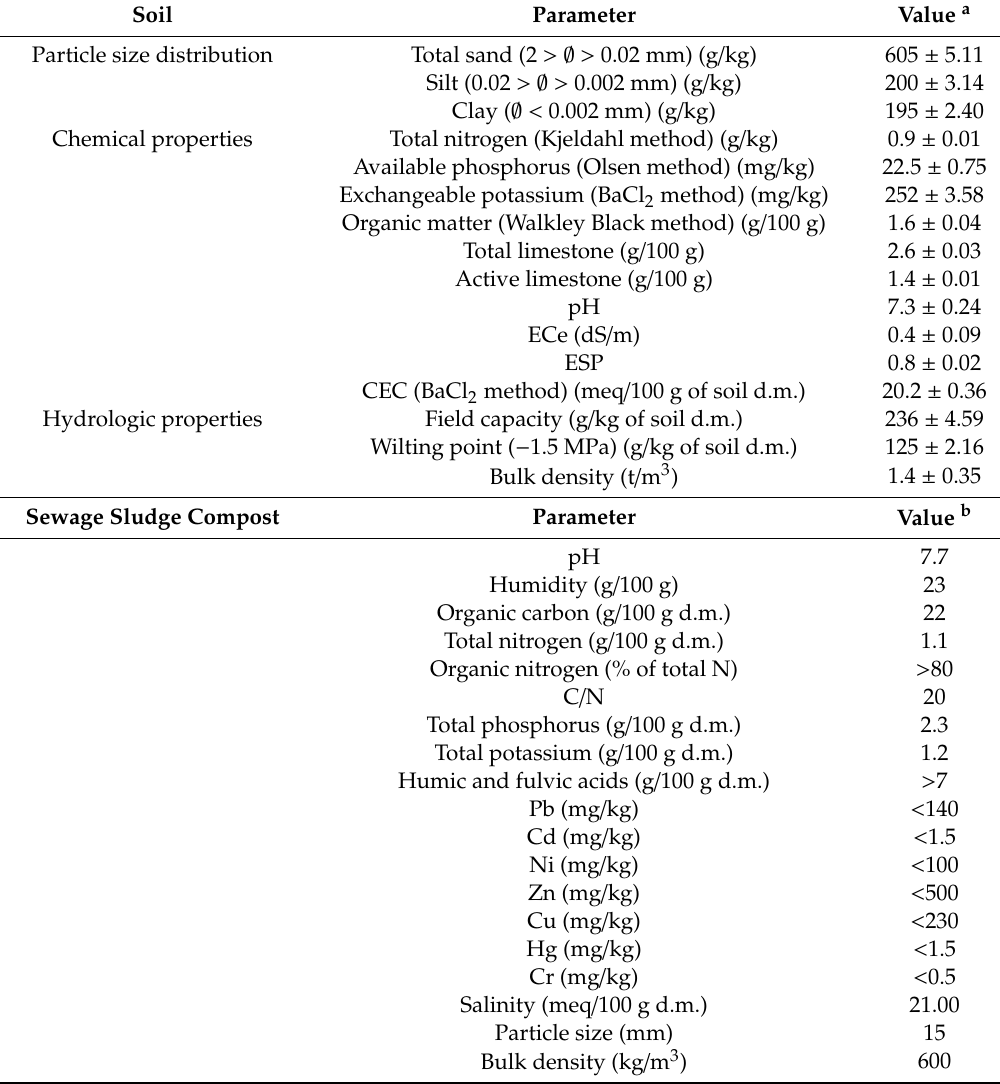
Table 1. Soil properties and main chemical-physical characteristics of the soil and sewage sludge